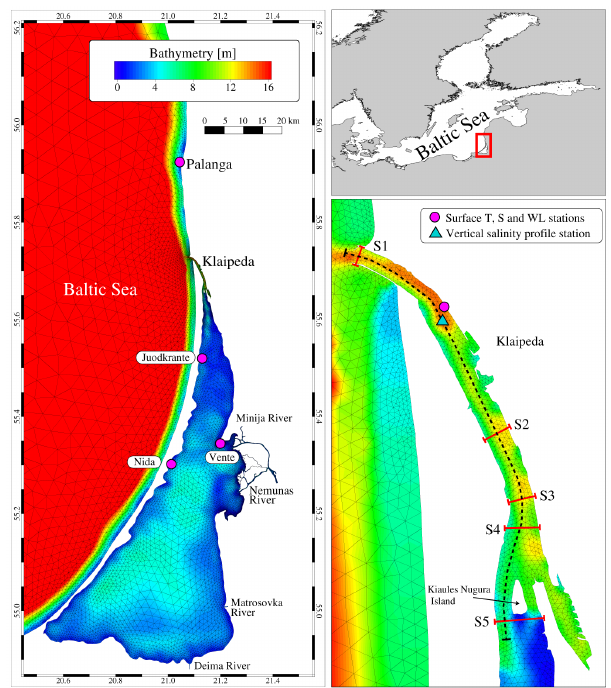
Fig. 1. Computational finite element grid of the Curonian Lagoon and coastal area of the Baltic Sea with a zoom on the Klaip˙eda Strait. Red continuous lines mark the location of cross-sections (S1– S5) and the black dashed line marks the along-strait section. The magenta circle marks the location of the surface salinity, sea sur- face temperature and water level continuous monitoring stations (Klaip˙eda harbour station is shown on the magnified part on the right) and the cyan triangle marks the location of the vertical salin- ity profile